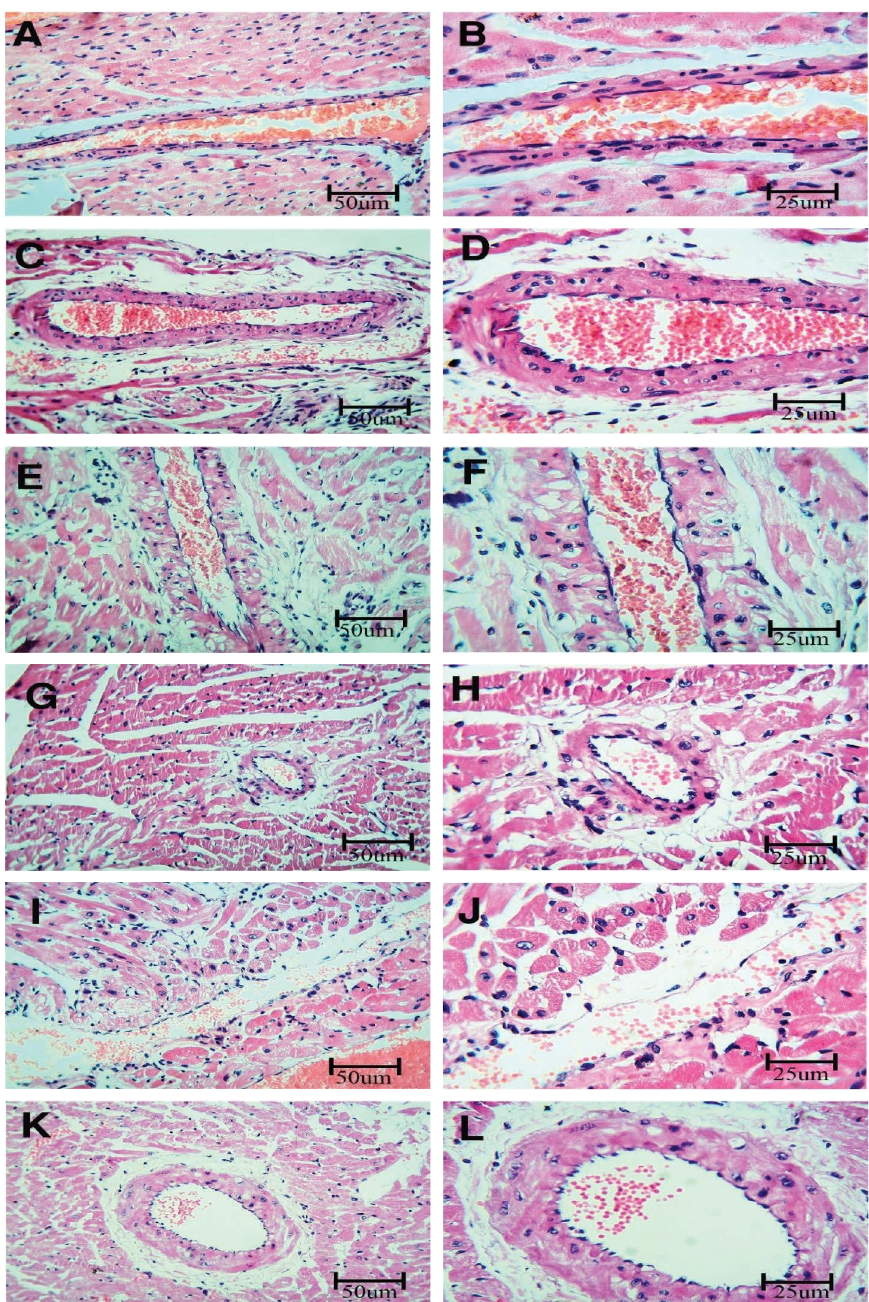
Figure 1: Histopathological section in the coronary artery of a rat stained with hematoxylin and eosin. a, b, c, and d are the control group; e, f, g, and h are the BPA group; and i, j, k, and l are the BPA+LC group. Te L.S. sections (a and b) of the coronary artery of the control group and c and d are the T.S. section showing the normal structure of the artery with thick media rich in acidophilic elastic fbers and regular endothelium. Te sections of the BPA group show weak acidophility and vacuolation of cells in the media and detachment of the en- dothelium of the intima of the artery. Tis picture is not marked in the BPA +LC group (HE stain; A, C, E, G, I, and K X 200; B, D, F, H, J, and L X